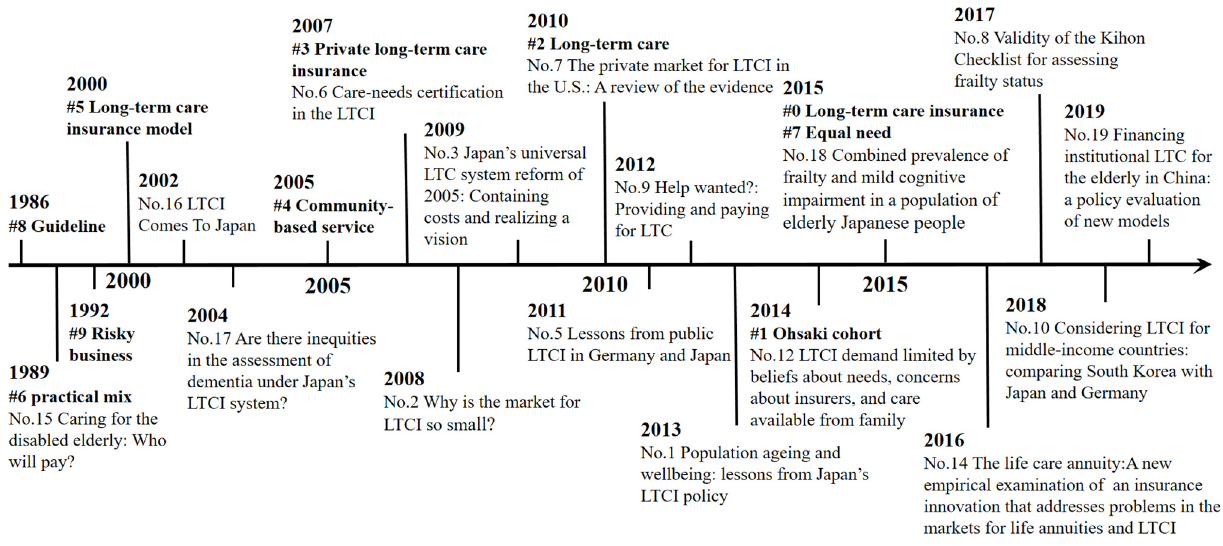
Figure 7. Timeline of the 10 largest clusters and 16 burst references. Note: # represents a knowledge cluster.